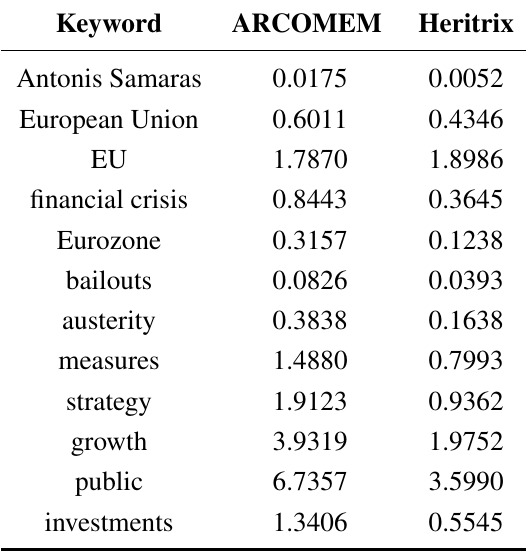
Table 3. Percentage of crawled documents containing keywords from ICD. Keyword